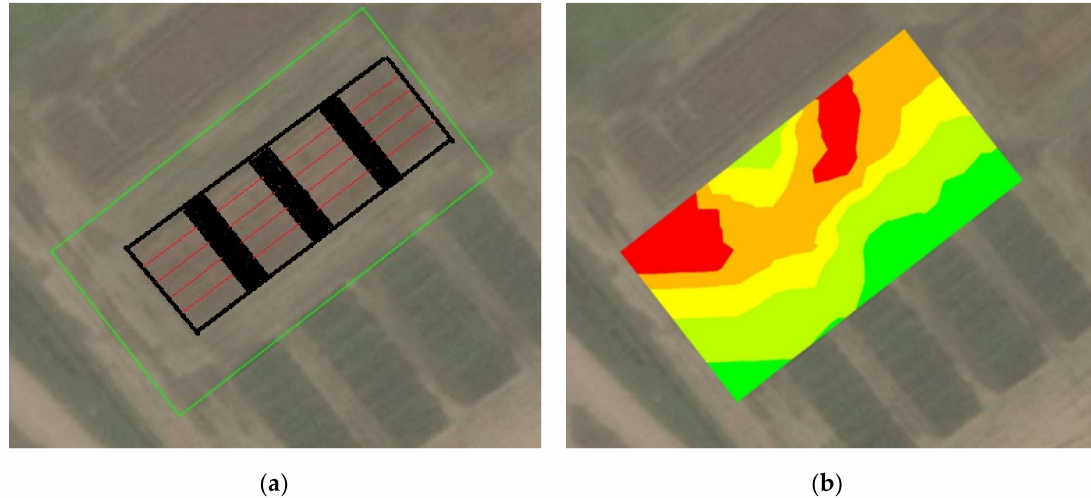
Figure 1. Map of the experimental site: ( a ) actual, experimental blocks with plots presented; ( b ) electrical conductivityofthesoil(0–30cmsoillayer). Coordinates: 54 ◦ 52 (cid:48) 57”Nlatitudeand23 ◦ 50 (cid:48) 51”Elongitude.